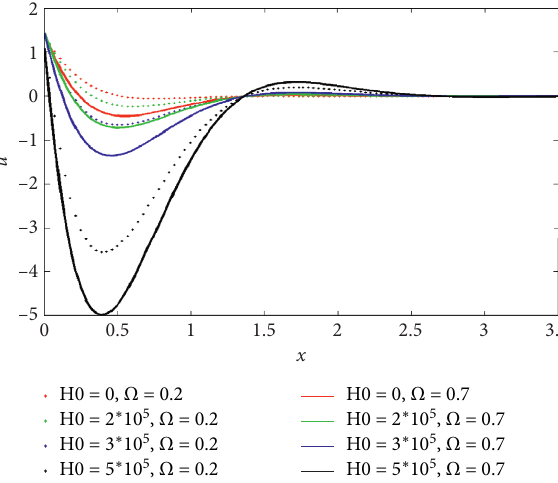
Figure 26: Horizontal displacement u concerning x with magnetic and rotation.